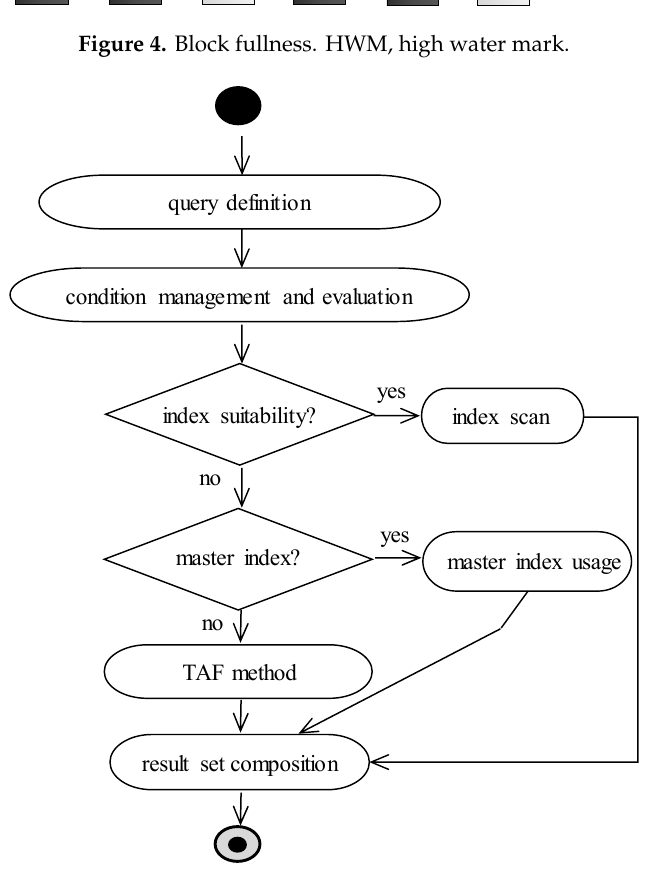
Figure 5. Data flow—Index access selection.